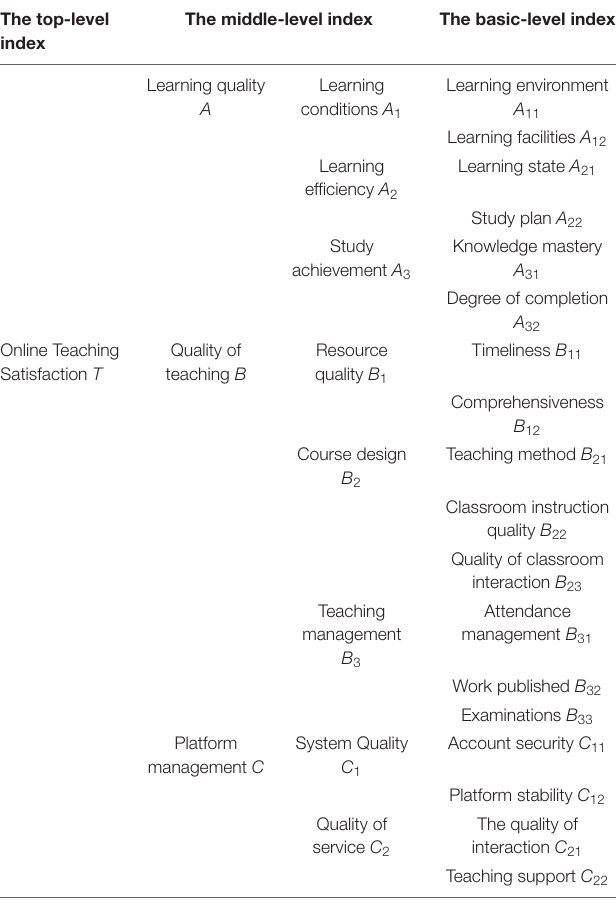
TABLE 1 | Evaluation index system of online